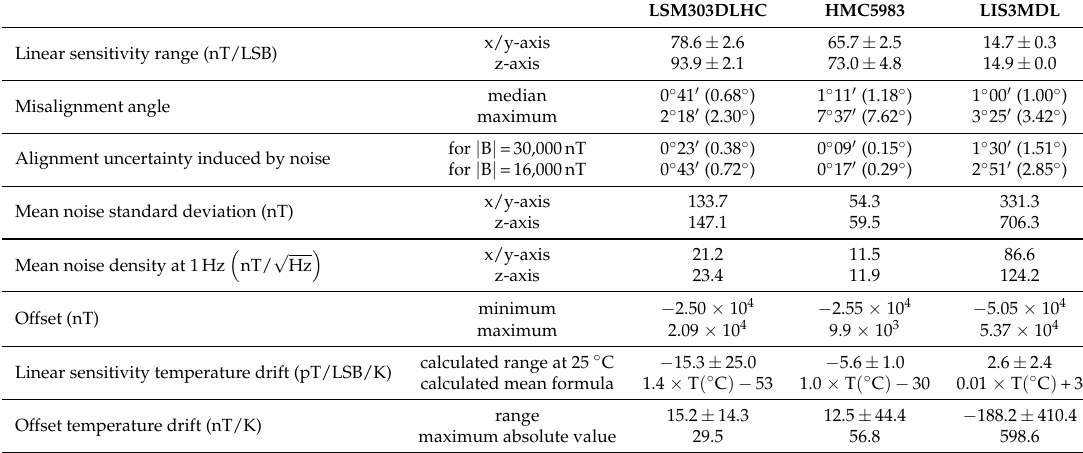
Table 1. Important calibration parameters of the three sensor models. Range values take into account all sensors of the same model and show the maximum value